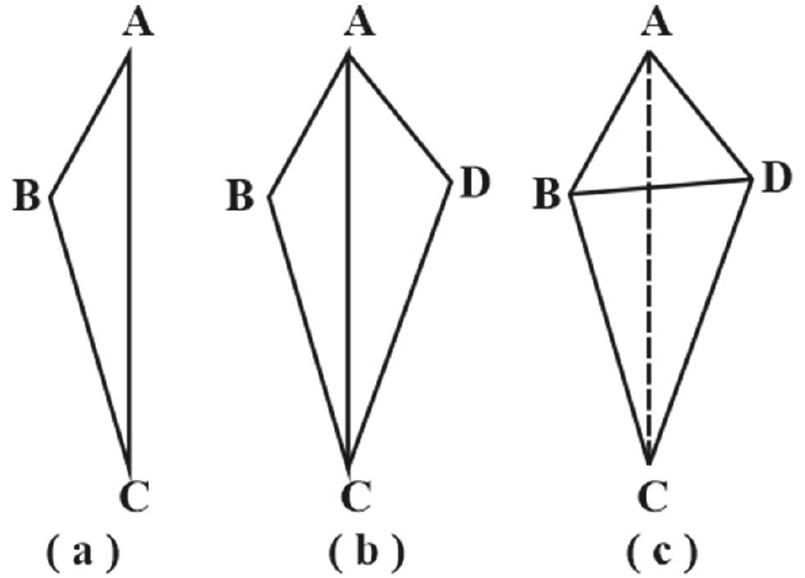
Figure 4. Lawson’s LOP rule: the diagonal of the quadrilateral is changed to meet the maximum– minimum angle criterion. ( a ) Initial Triangle. ( b ) Triangulation Network after Insertion Point D. ( c ) Modified Triangulation Network.